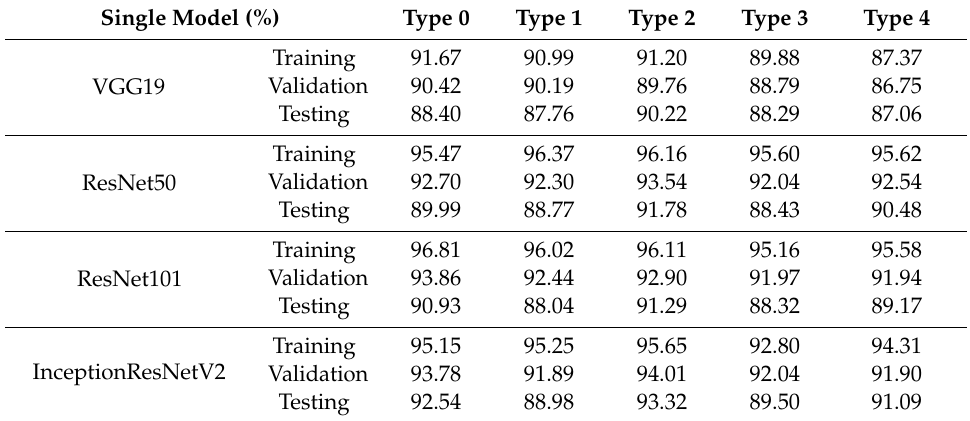
Table 11. Classification performance for 11 classes without augmentation under nontransfer learning. Single Model (%)